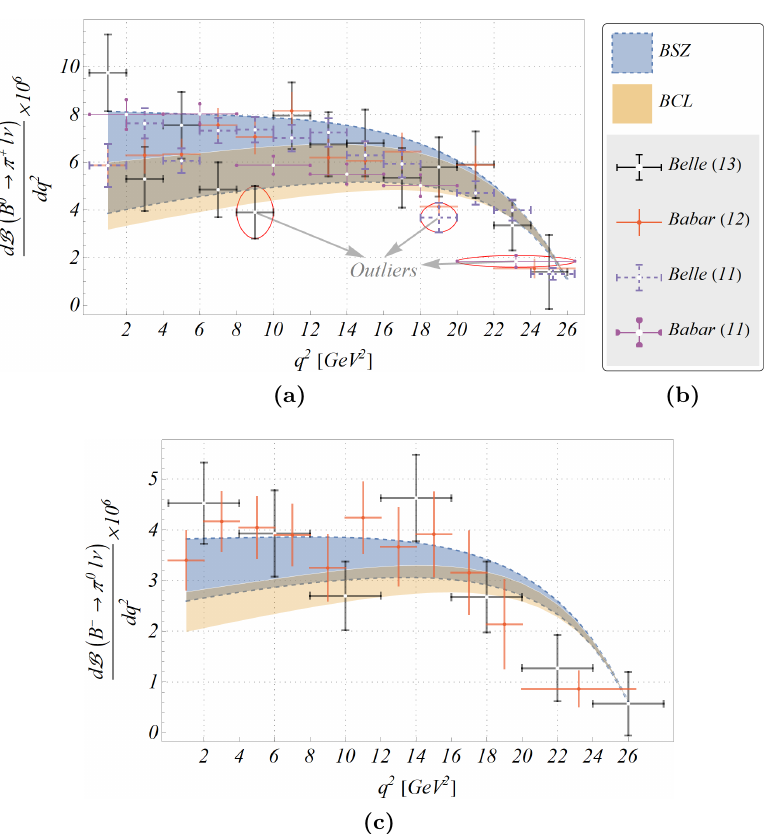
Figure 2 . Differential branching fraction plots superposed on experimental data-points, with form factors fitted from lattice and LCSR, and V